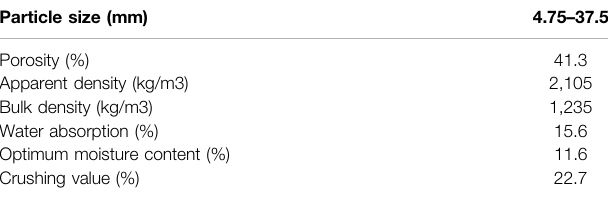
TABLE 2 | Performance indicators of the recycled